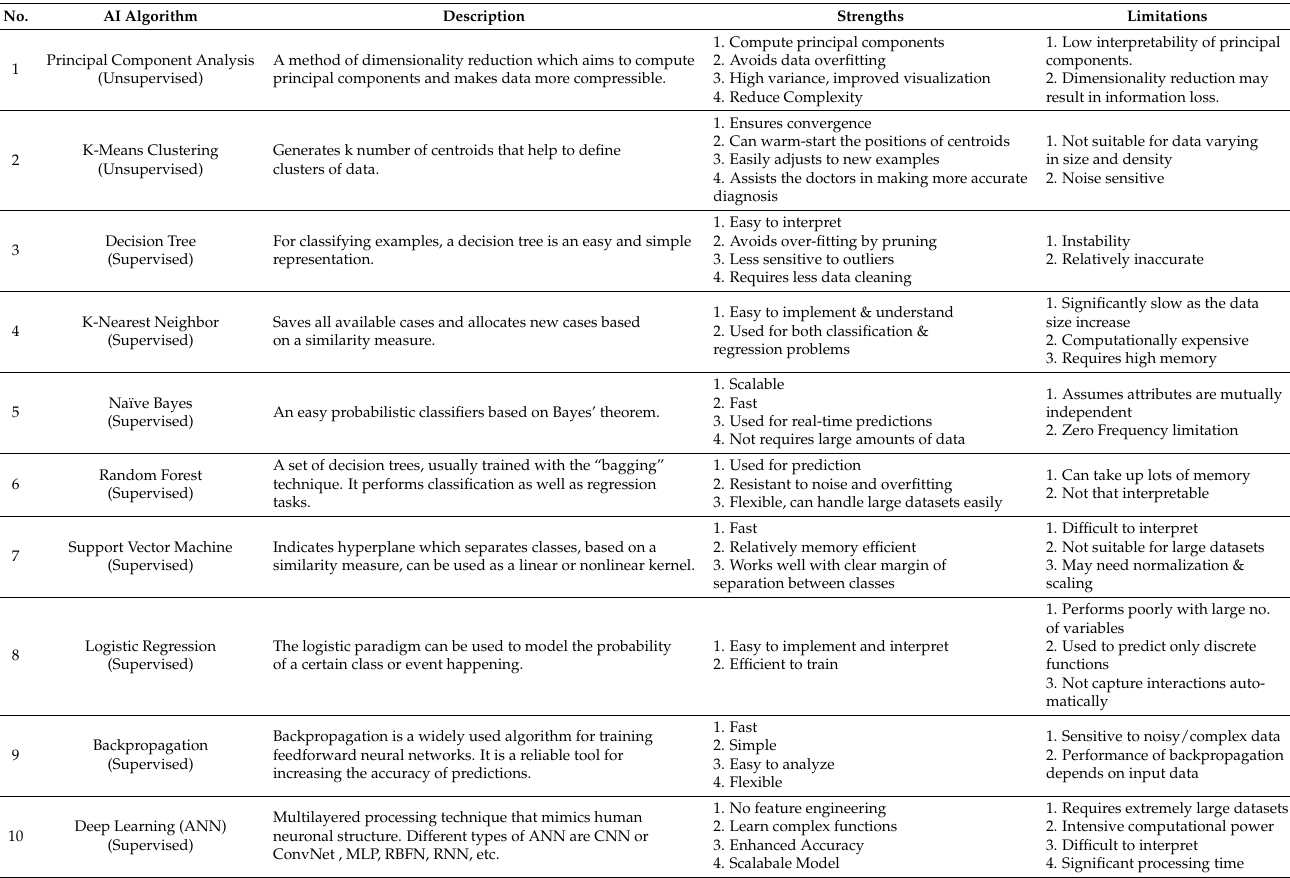
Table 12. Overview of common ai techniques used in